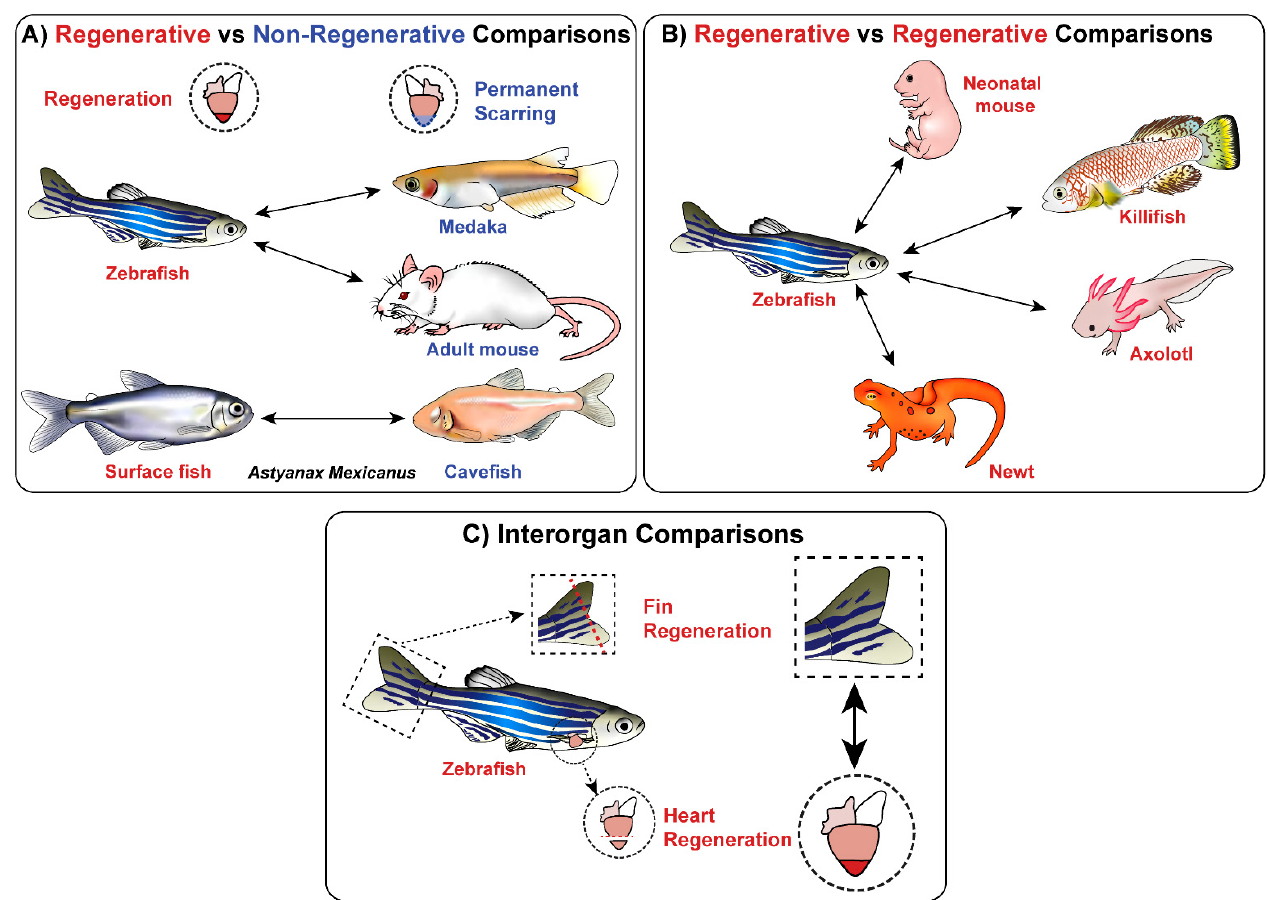
Figure 1. A summary of the three comparative approaches and how they have been used so far in the study of cardiac regeneration. ( A ) Interspecies comparisons between the zebrafish and the non-regenerative medaka and adult mouse have been made whilst intraspecies comparisons have been made between the regenerative and non-regenerative morphotypes of A. mexicanus . ( B ) Interspecies comparisons have been made between the zebrafish and the regenerative killifish, neonatal mouse, axolotl and newt. ( C ) Interorgan comparisons have been made between heart and fin regeneration in the zebrafish.